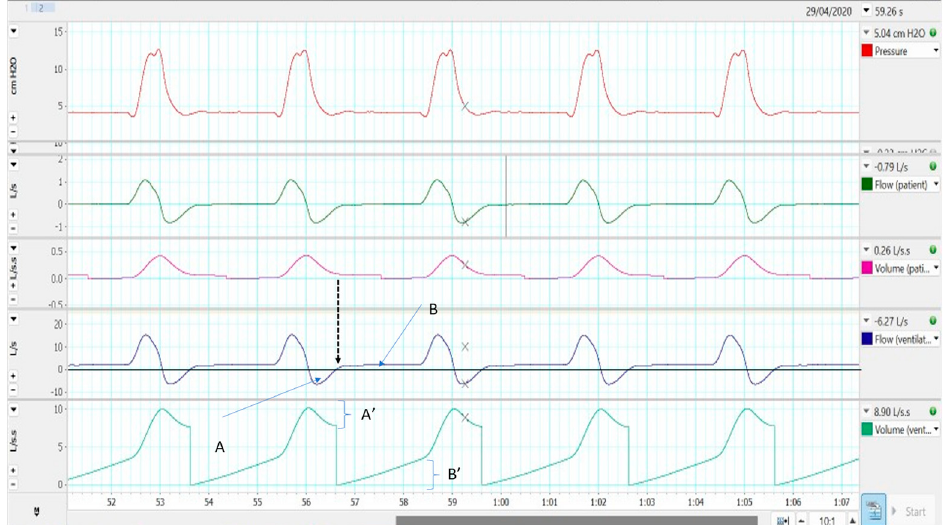
Figure 3. Gas flow dynamics in a bench model of single limb with intentional leakage. See the text for more details.